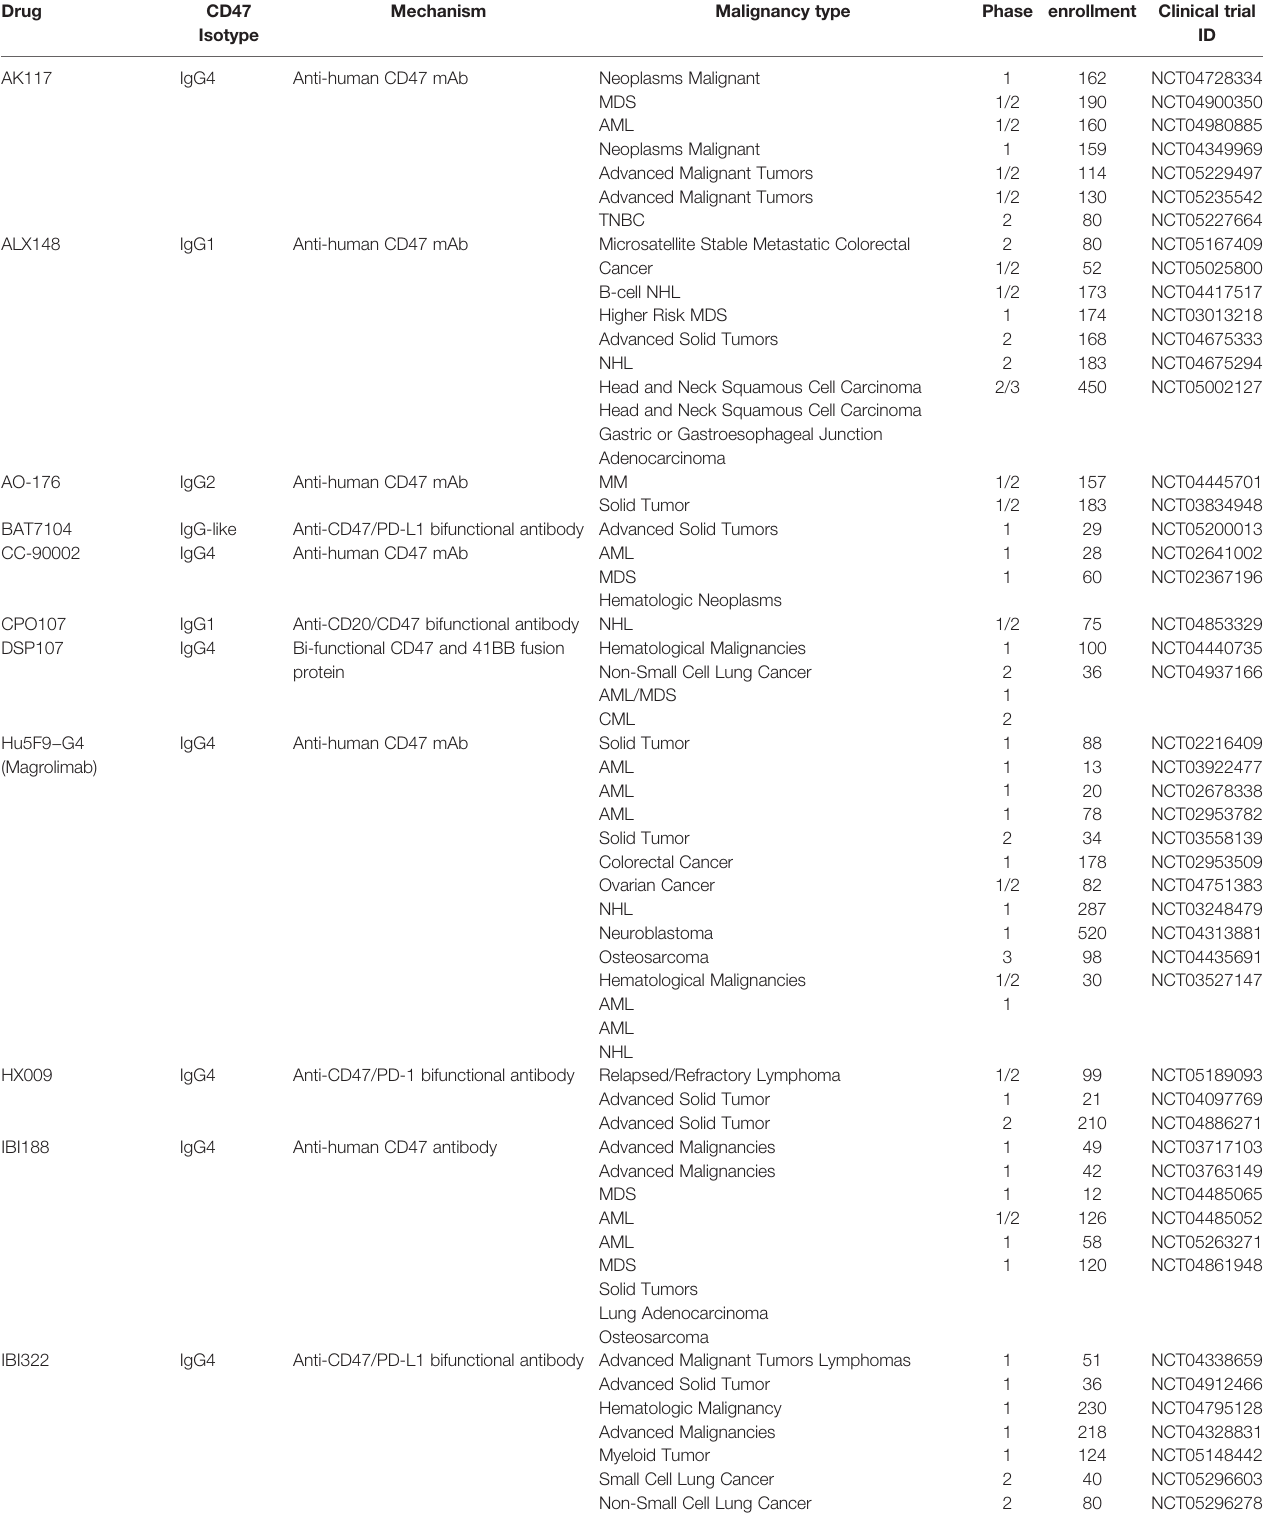
TABLE 1 | Clinical trials targeting CD47 registered with the National Clinical Trials Registry (NCT)